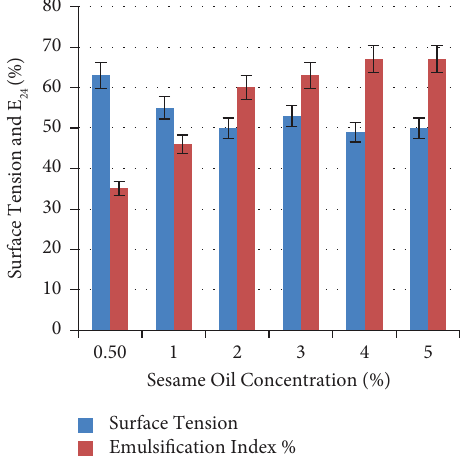
Figure 8: Efect of diferent sesame oil concentrations on bio- surfactant production. 4% was the best concentration with better values of E 24 % (67 ± 0.33%) and surface tension 49 ± 0.67mN/m.